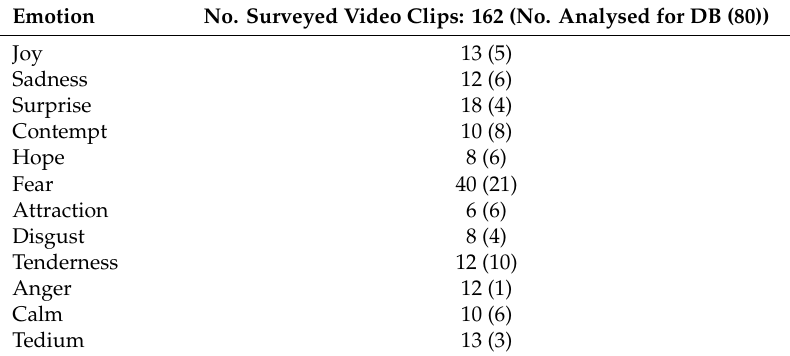
Table 2. Number of video clips per target emotion surveyed and analysed.